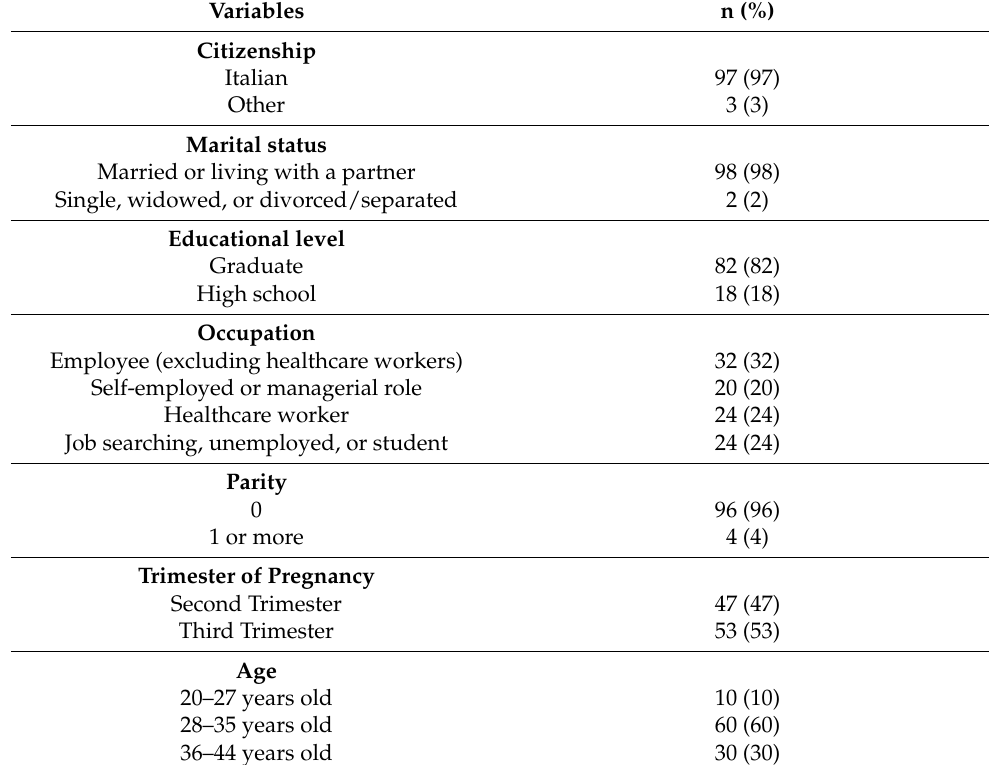
Table 1. Sociodemographic and pregnancy-related characteristics (N =